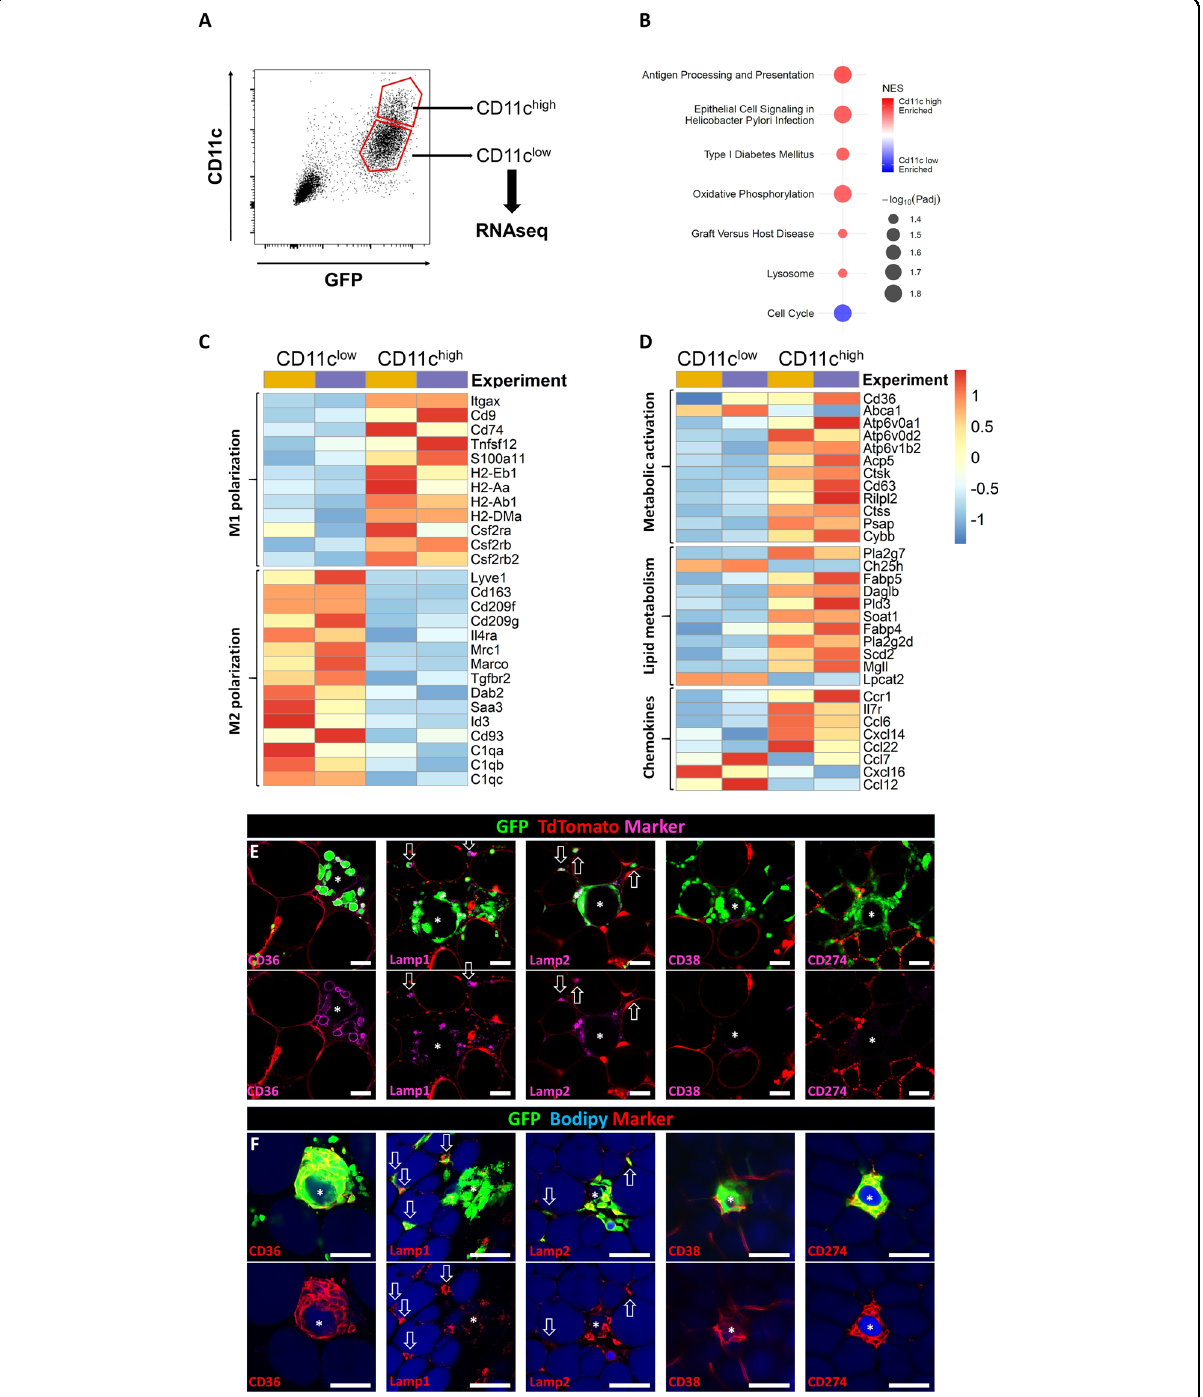
Fig. 6 RNA sequencing reveals metabolic activation following adipocyte death. A GFP positive cells were sorted in CD11c high and CD11c low groups for RNA sequencing 48 h following laser injury. B Pathway analysis of gene expression pro fi les between the sorted groups. C , D Heatmaps comparing differentially expressed genes related to either M1 or M2 polarization ( C ) or associated with metabolic activation, lipid metabolism or chemokines and their receptors ( D ). Colors indicate the log 2 fold change of gene expression in the 2 individual experiments from average across all samples. Expression of genes shown is signi fi cantly different between CD11c high and CD11c low group ( p < 0,001). E Expression of markers differentiating between M1 polarization (CD38, CD274) and metabolic activation (CD36) and markers for lysosomal exocytosis in induced CLS. F Expression of the respective markers in vivo in lean mice. Asterisks mark adipocytes within CLS, positive interstitial ATMs are highlighted by arrows. Scale bars = 50